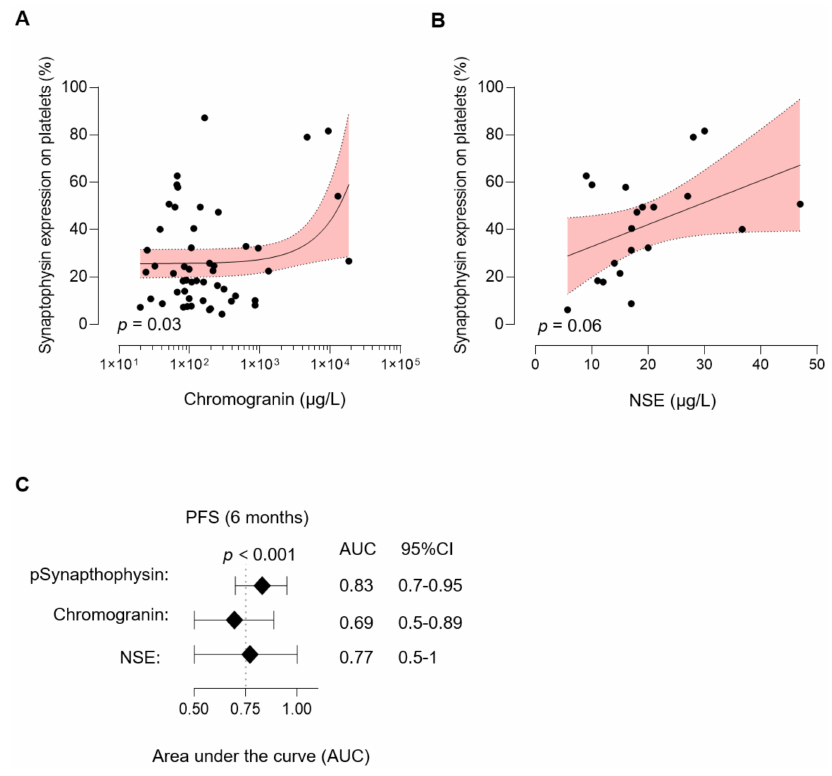
Figure 5. Association of pSyn with routine biomarkers in NEN. ( A ) Correlation of pSyn and CgA. Line indicates linear regression, gray area 95% CI interval. ( B ) Correlation of pSyn and NSE. Line indicates linear regression, gray area 95% CI interval. ( C ) Predictive value of pSyn, CgA, and NSE for PFS (6